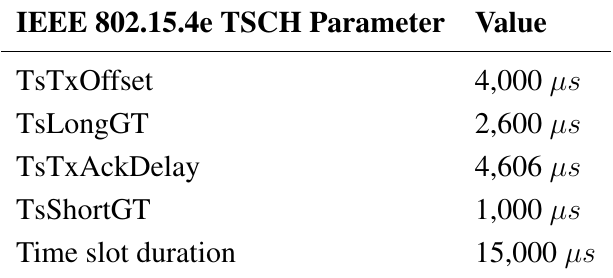
Table 1. Time slot timing. TSCH, time-slotted channel